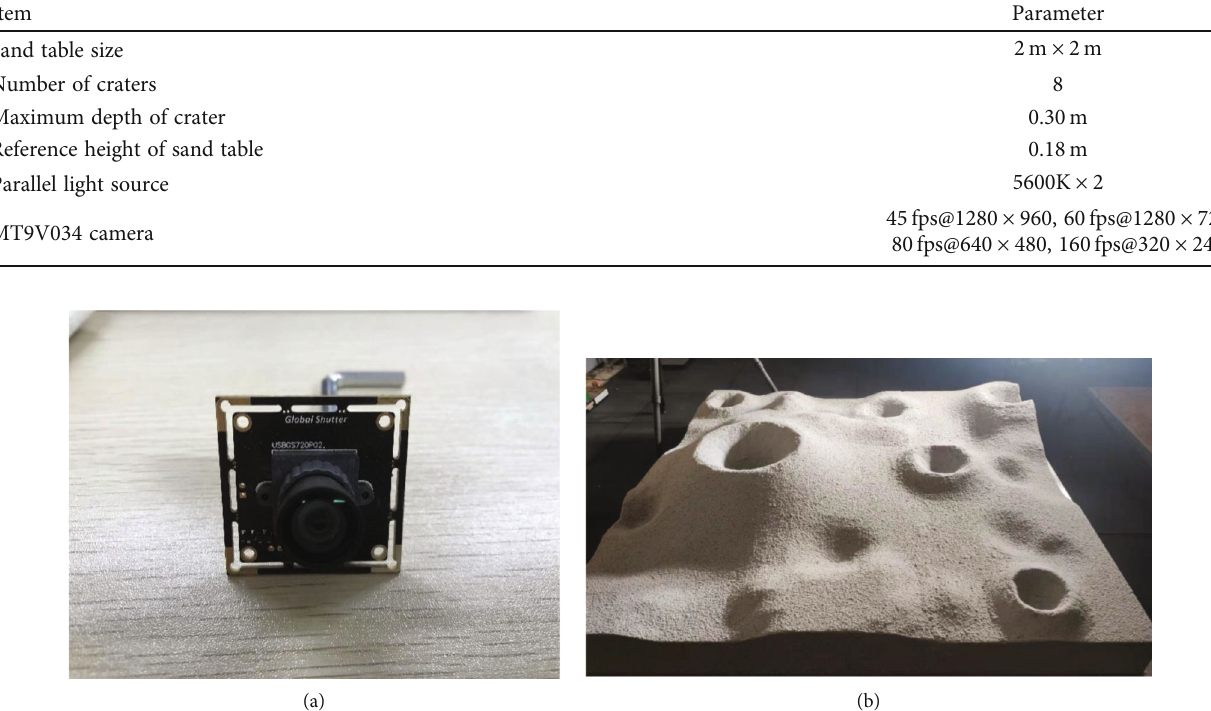
Table 2: Experience conditions.